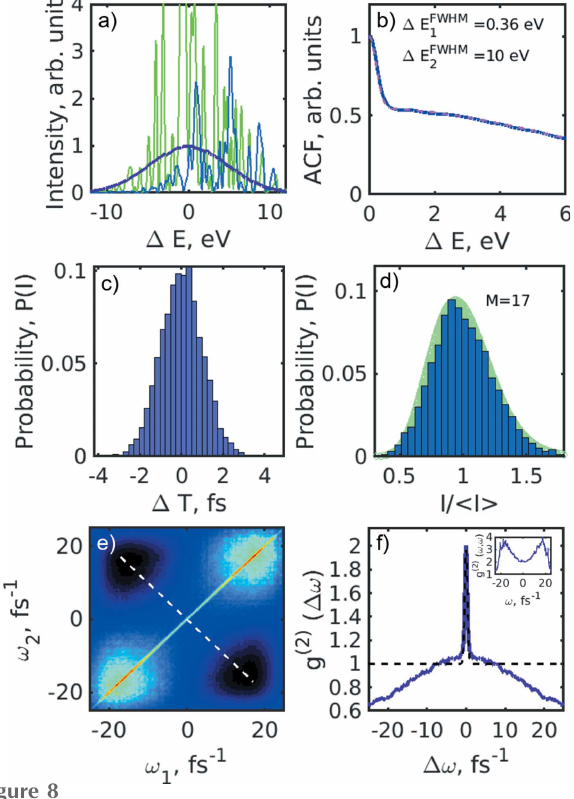
Figure 8 Spectral analysis simulation with an energy jitter of 5 eV (FWHM) and additional pulse duration jitter of 1 fs (r.m.s.). ( a ) Typical single-shot simulated spectra and an averaged spectrum (blue line). ( b ) Autocorrela- tion function of individual spectral lines averaged over 5 (cid:4) 10 3 pulses (blue line) and the fit with the two Gaussian functions (magenta dashed line). ( c ) Histogram of the pulse duration distribution. ( d ) Histogram of the spectral pulse intensity distribution (blue). The green background corresponds to the gamma probability distribution function with number of modes M = 17. ( e ) Second-order intensity correlation function g (2) ( ! 1 , ! 2 ) of the simulated spectra. ( f ) Second-order intensity correla- tion function g (2) ( (cid:2) ! ) taken along the white dashed line in ( c ) and its fit (black dashed line) with equation (9). Additional features around (cid:2) ! = 0 are easily seen in this panel. In the inset the profile of the g (2) ( ! , ! ) function along the diagonal in ( e ) is